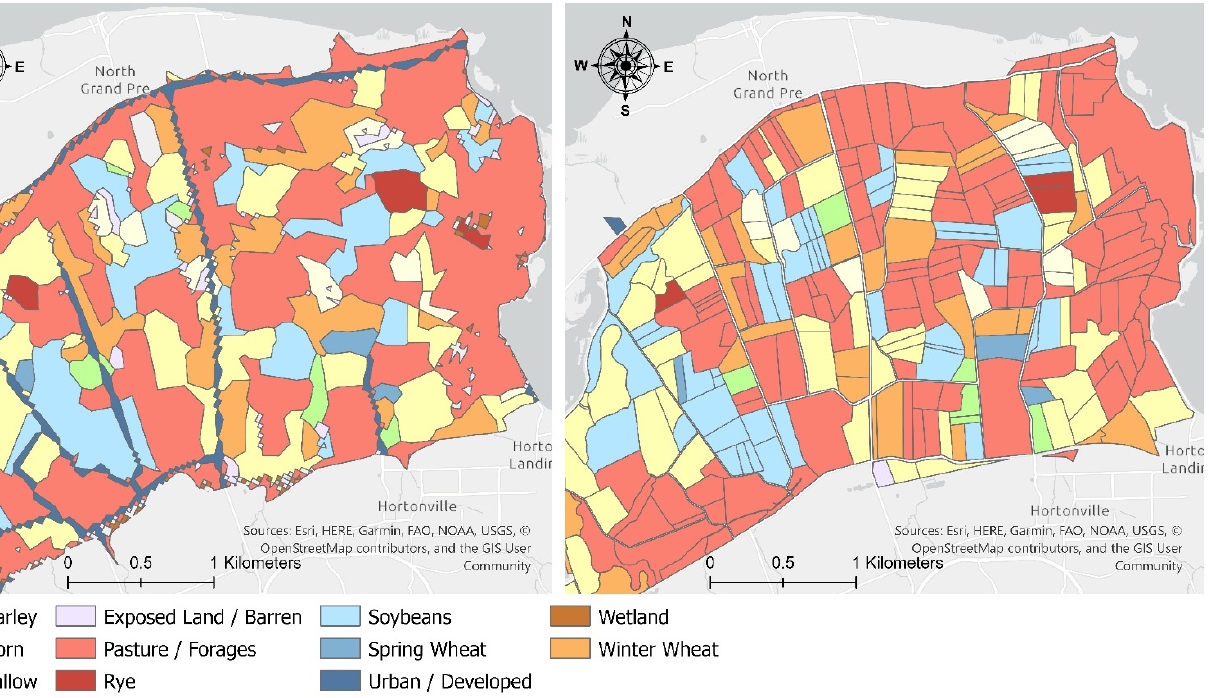
Figure 3. Examples of the Annual Crop Inventory in Grand ‐ Pré, Nova Scotia ( left ) and assigned to property boundary from the NSPRD ( right ).